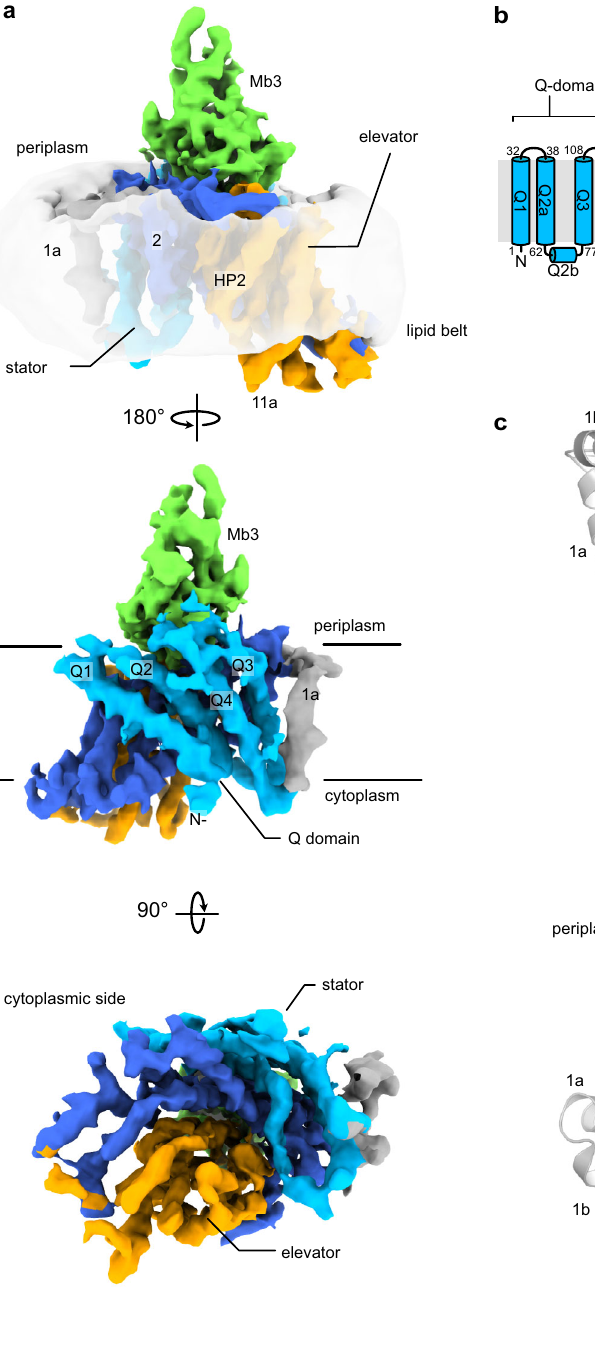
Fig. 1 Cryo-EM structure of the TRAP transporter HiSiaQM. a 3D reconstruction of HiSiaQM in complex with Mb3 in lipid nanodiscs (contour level 0.384). A map of the nanodisc was overlayed in transparent grey to show the relative position of the lipid bilayer. Selected secondary structure elements are indicated. The individual domains and their color code are identi fi ed in panel ( b ). b Topology diagram of HiSiaQM. c Cartoon representation of HiSiaQM with the same color scheme as in ( a ) and ( b ). Secondary structure elements are